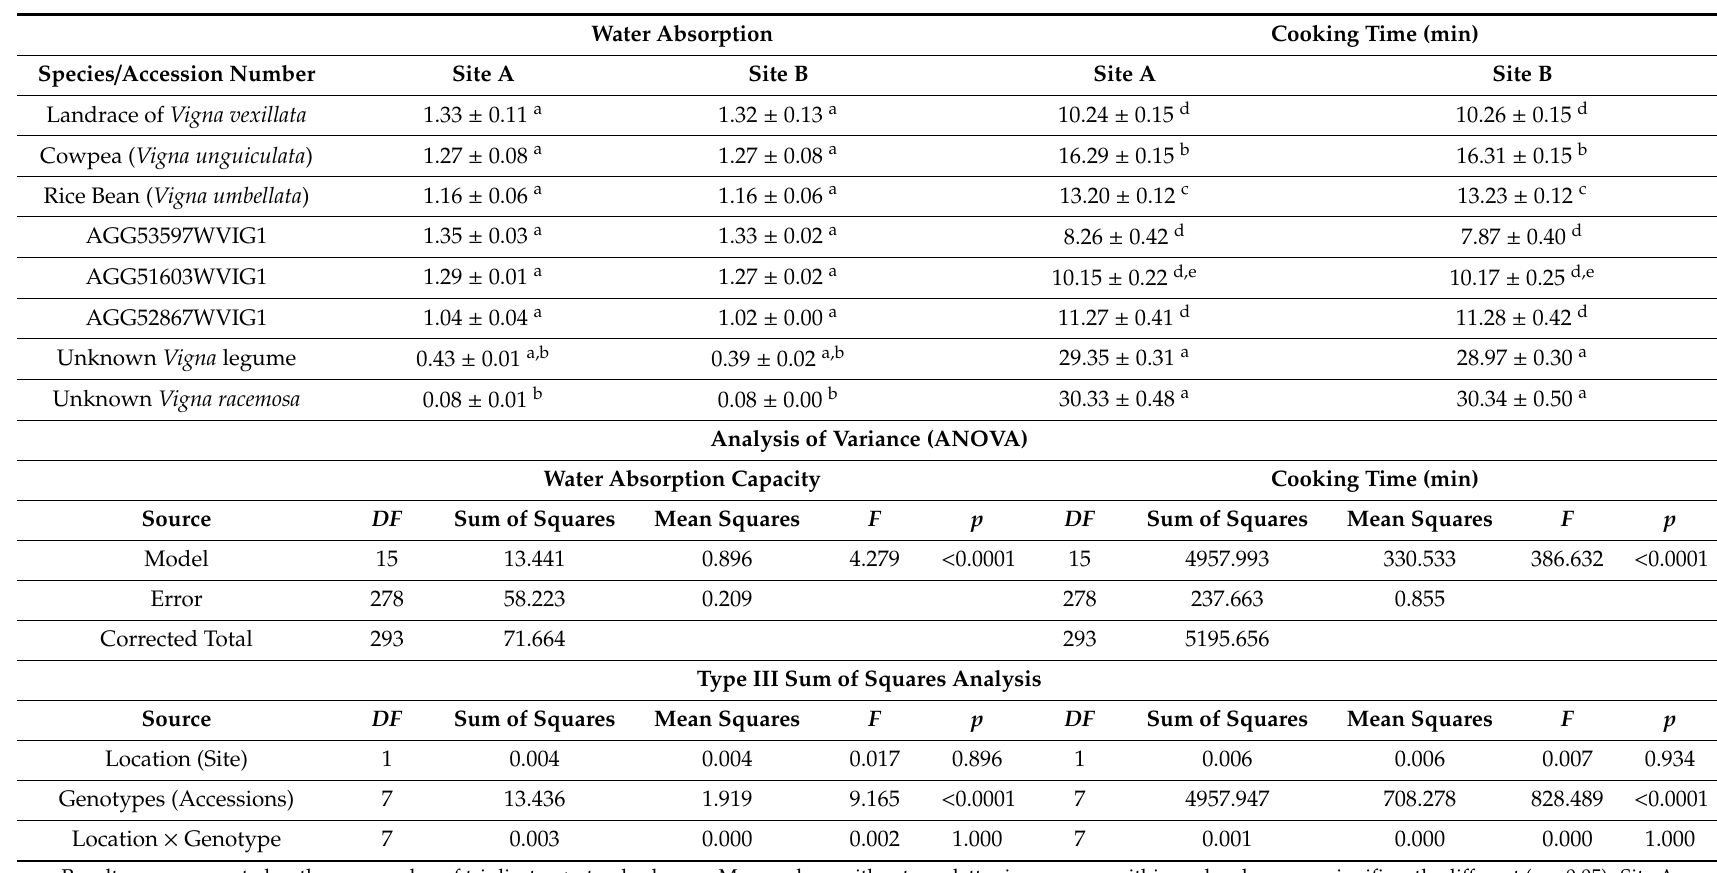
Table 6. Cooking time and water absorption capacity of Vigna racemosa